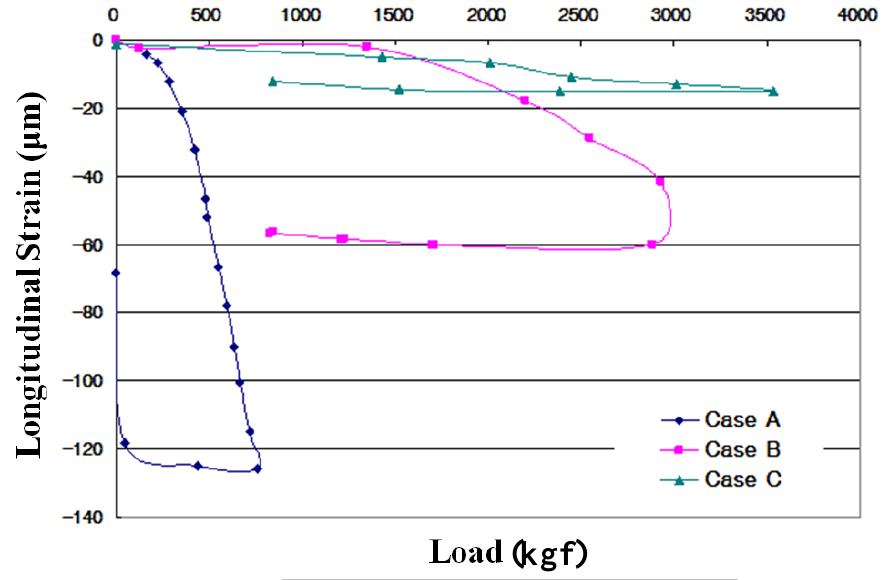
Figure 10. The longitudinal strain of the PVC